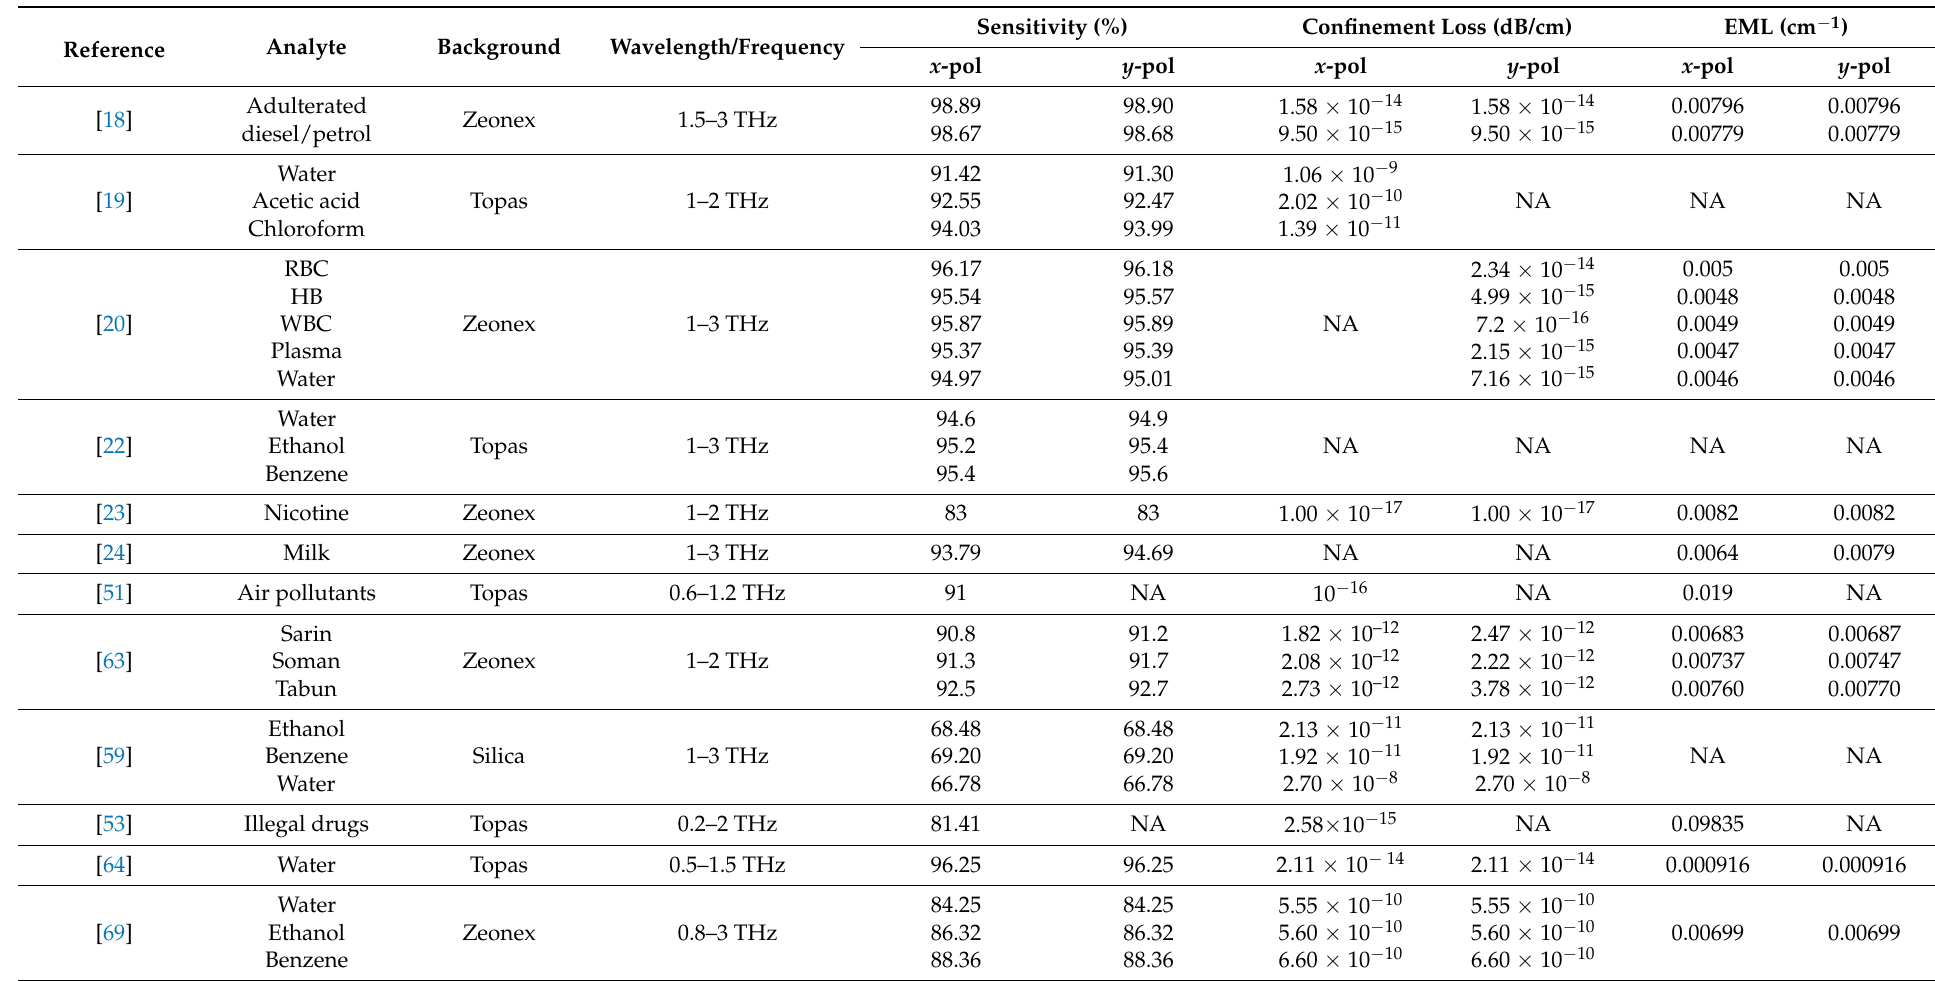
Table 4. Comparison between the guiding parameters of the suggested biosensor with the sensors in the literature. NA: Not